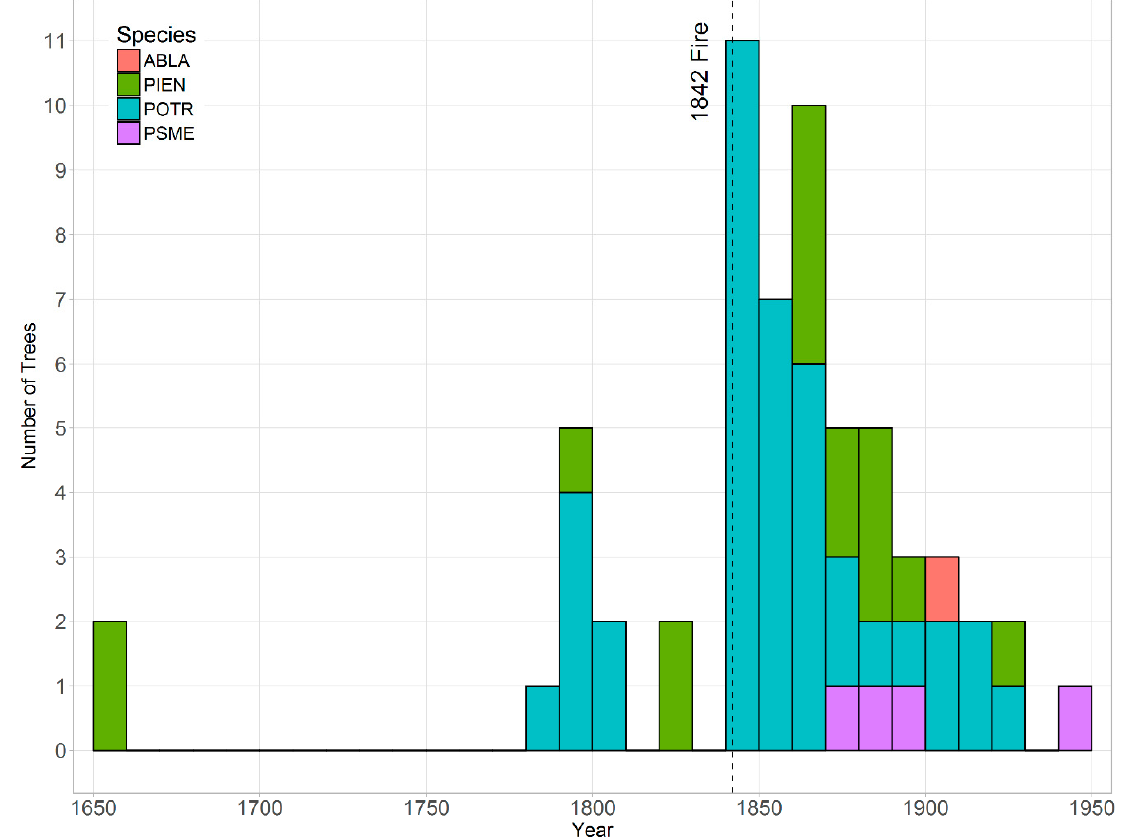
Figure 8. The inner-ring dates of the sampled living trees binned by decade in the upper Rio Hondo and Taos Ski Valley. The vertical dotted line indicates the year (1842) of a high-severity fire determined from aspen recruitment dates, fire scars from lower elevations, and historical photographs. All trees sampled within the 1842 fire patch had inner rings ≥ 1842 (see Figure 7). Species abbreviations: Populus tremuloides (POTR), Pseudotsuga menziesii (PSME), Picea englemannii (PIEN), and Abies lasiocarpa (ABLA).